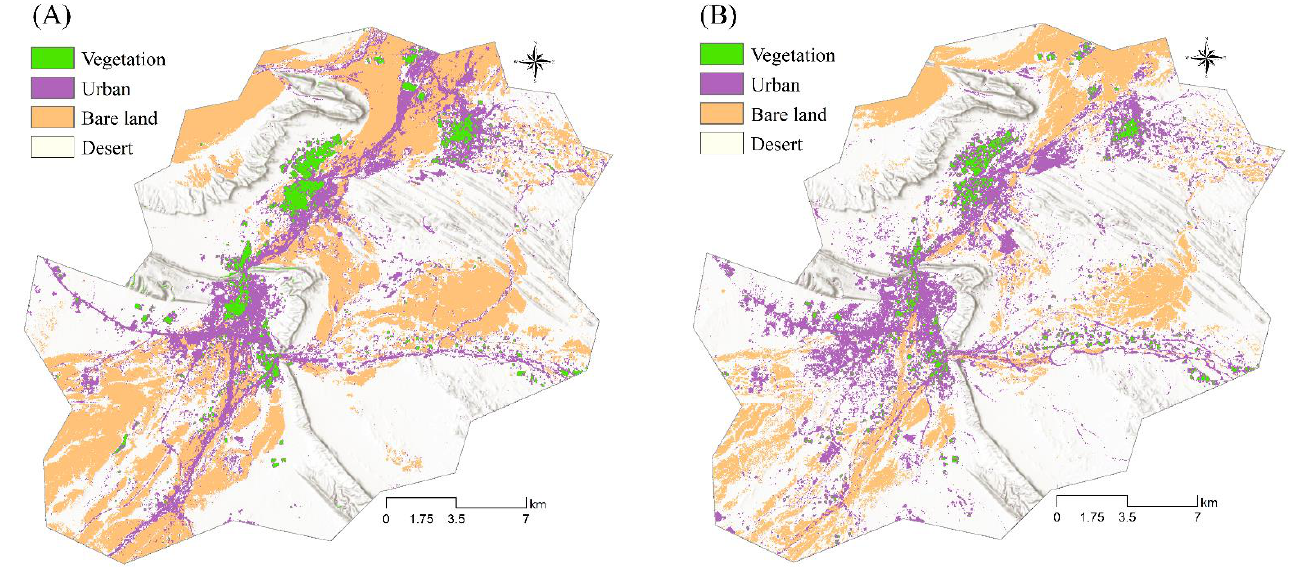
Figure 6. Historical changes in LULC between 2010 ( A ) and 2020 ( B ). Table 5. Observed LULC between 2010 and 2020. LULC Type Area in 2010